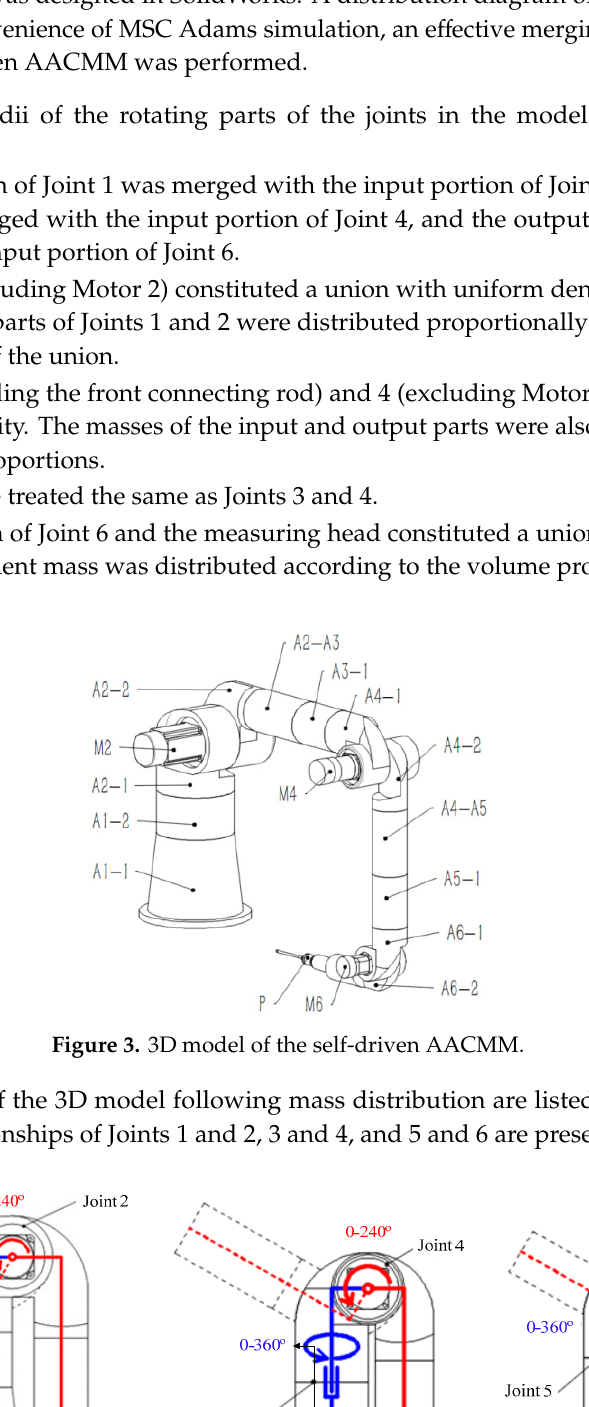
Figure 4. Schematic diagram of the angle ranges and hinge relationships of each joint, they should be listed as: ( a ) Description of what is Joints 1 and 2, ( b ) Description of what is Joints 3 and 4, ( c ) Description of what is Joint 5 and 6.